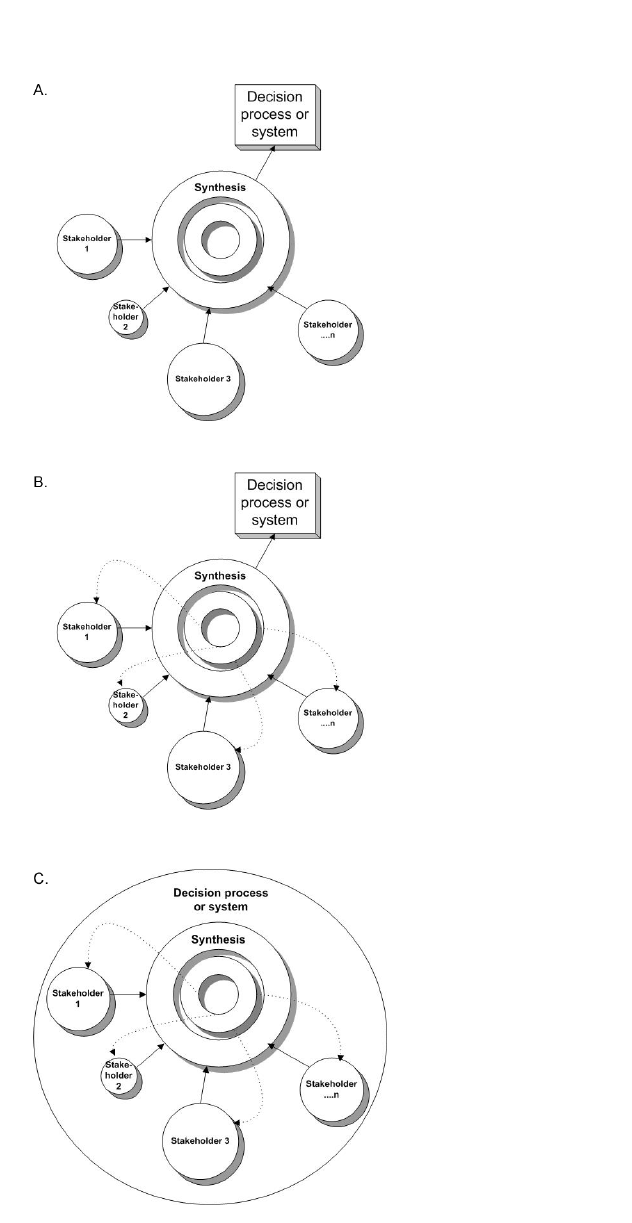
Fig. 1 . Modes of knowledge capture and use when making decisions about natural resources. The different-sized stakeholder objects represent the role of stakeholder knowledge and power. The solid arrows represent the contribution of these stakeholders to the process of synthesizing knowledge or understanding, which is represented as the outer cylinder. The final synthesized knowledge is represented as the inner cylinder. The dotted lines represent the uptake of this newly synthesized knowledge by the stakeholders. (A) Extractive use, in which knowledge, values, or preferences are synthesized by the extracting group and passed on as a diagnosis to a decision-making process. (B) Co- learning, in which syntheses are developed jointly and the implications are passed to a decision-making process. (C) Co-management, in which the participants perform the syntheses and include them in a joint decision-making